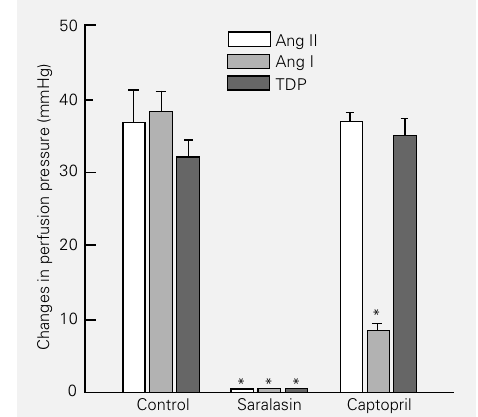
Figure 2 - Changes in perfusion pressure in the isolated rat